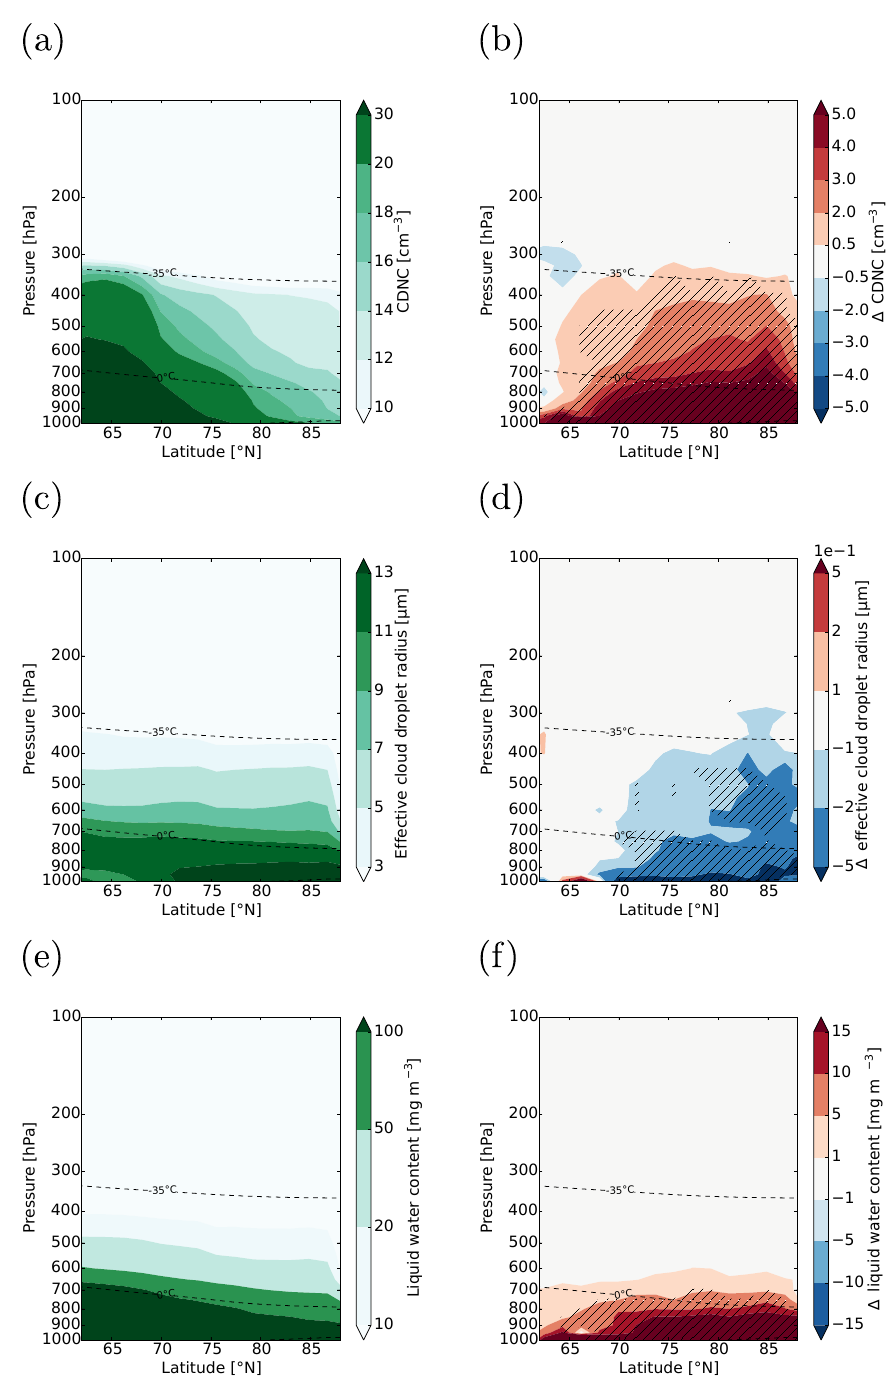
Figure 11. CDNC, effective cloud droplet radius, and LWC in late summer (July–August; in-cloud values): (a) , (c) , and (e) show the absolute values for 2050 (reference), (b) , (d) , and (f) the difference between a simulation with enhanced ship emissions and the reference simulation (difference between arctic_2050_shipping and arctic_2050). Hatched areas are significant at the 95% confidence level. The dashed lines show the 0 and the − 35 ◦ C